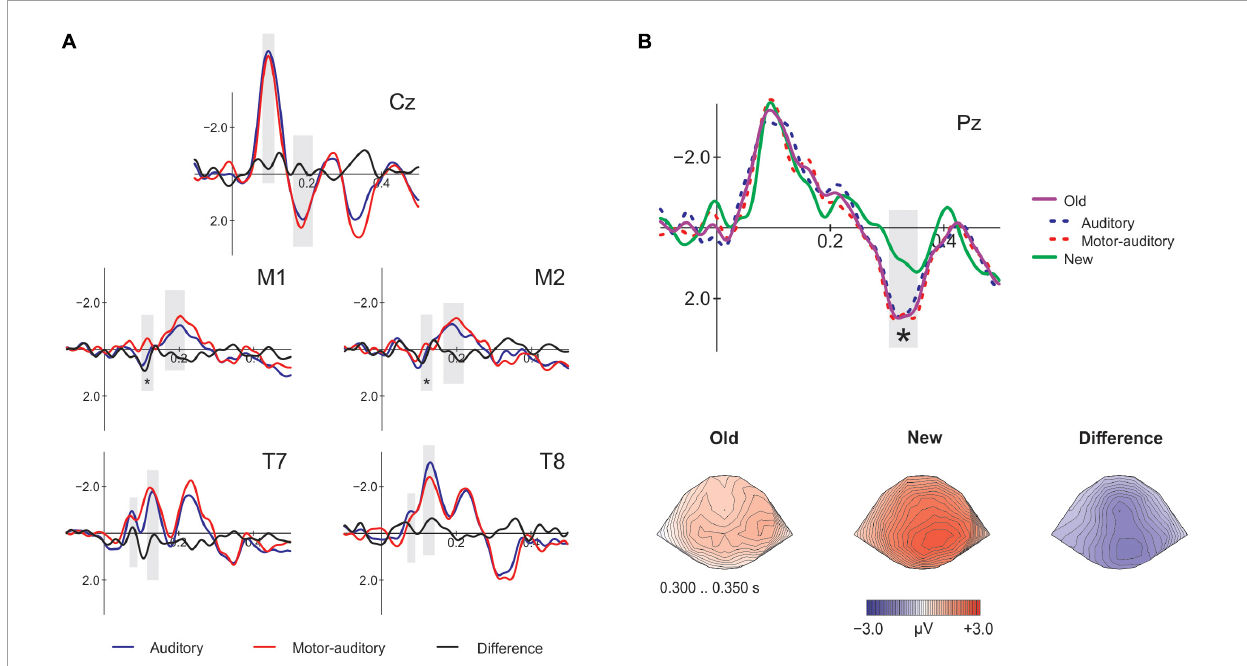
FIGURE3 Electrophysiological results at retrieval. (A) Event-related-potentials (ERPs) comparing the encoded as auditory and motor-auditory sounds, passively presented at retrieval on the analyzed electrodes. At Cz, M1 and M2 the analyzed components are N1 and P2, at T7 and T8 the N1 subcomponents Na and Tb. The gray shading marks the time windows of the amplitude analysis. Asterisks mark significance. (B) Top figure: ERPs at Pz comparing the old and the new conditions. Auditory and motor-auditory conditions are displayed here for visualization purposes. Bottom figure: topographical plots in the P3 time-window showing the distribution of the old/new